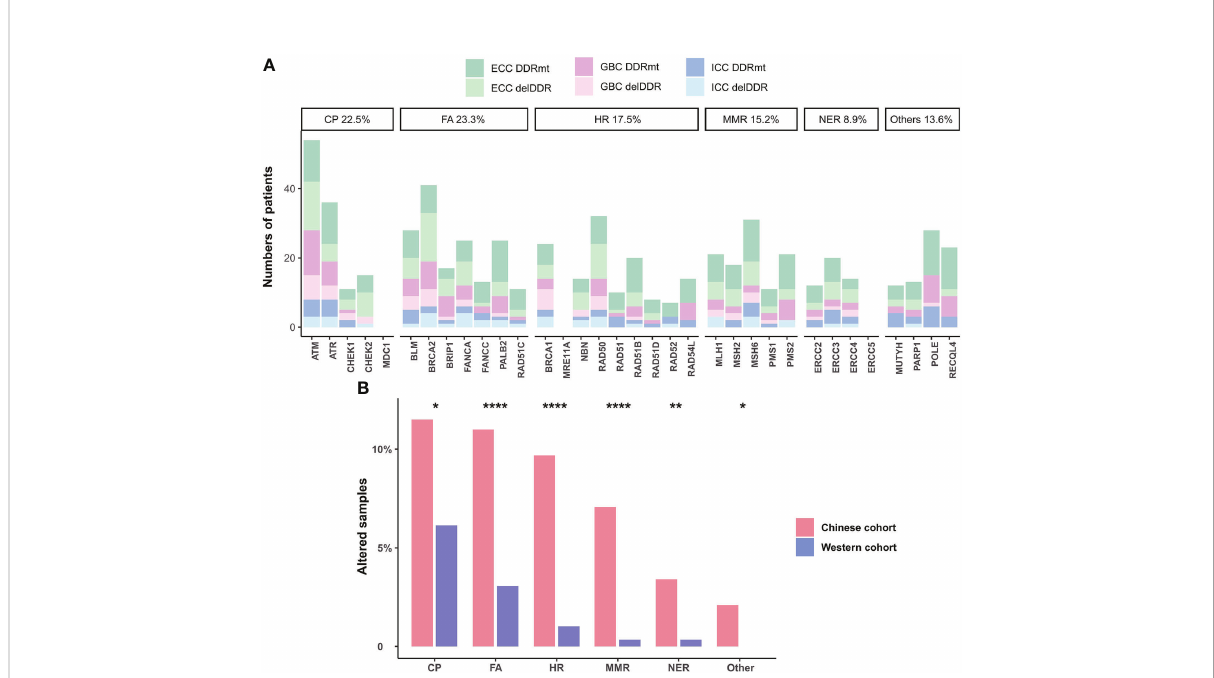
FIGURE 6 DDR alterations in BTC patients. (A) Distribution of somatic alterations in speci fi c DDR pathways of ICC, ECC, and GBC subtypes. Dark colors are non-deleterious DDR alterations, and light colors are deleterious DDR (delDDR) alterations. (B) Comparison of the prevalence of delDDR in different DDR pathways in Chinese and Western cohorts. * p < 0.05; ** p < 0.01; **** p < 0.0001. DDR, DNA damage repair; ICC, intrahepatic cholangiocarcinoma; ECC, extrahepatic cholangiocarcinoma; GBC, gallbladder carcinoma; delDDR: deleterious